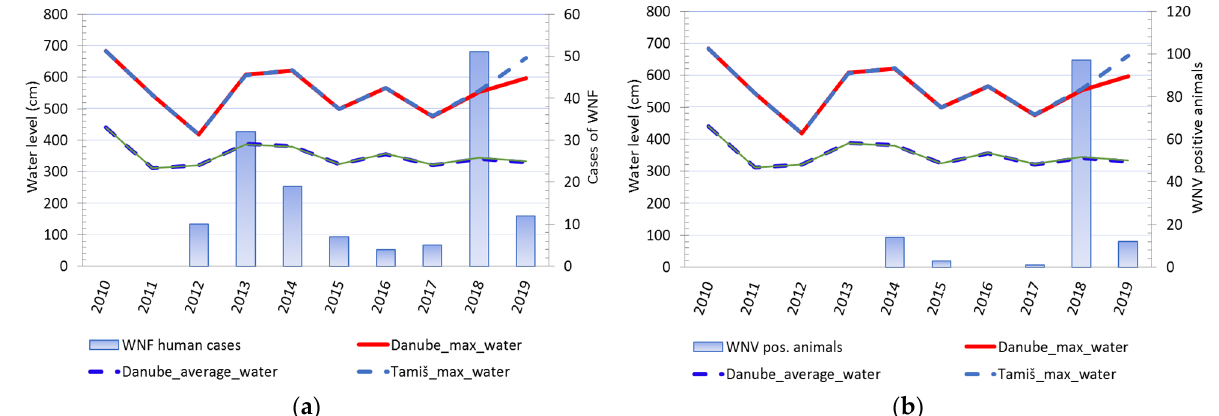
Figure 5. Water level fluctuations and registered cases of West Nile virus (WNV) infection in humans and animals over 10 years: ( a ) Water level fluctuations and registered number of WNV human cases; ( b ) water level fluctuations and registered cases of WNV seropositive animals.